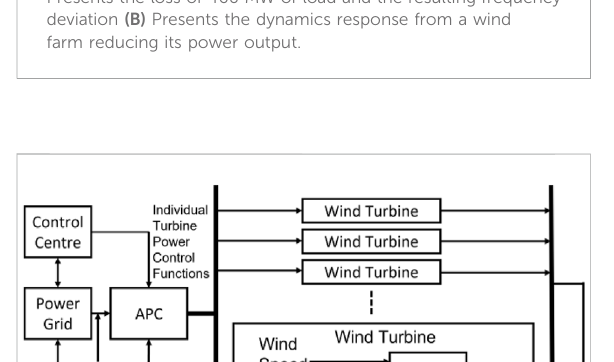
FIGURE 4 High frequency event on the Ireland ’ s power system following the loss -460 MW on the HVDC interconnector (A) Presents the loss of 460 MW of load and the resulting frequency deviation (B) Presents the dynamics response from a wind farm reducing its power output.